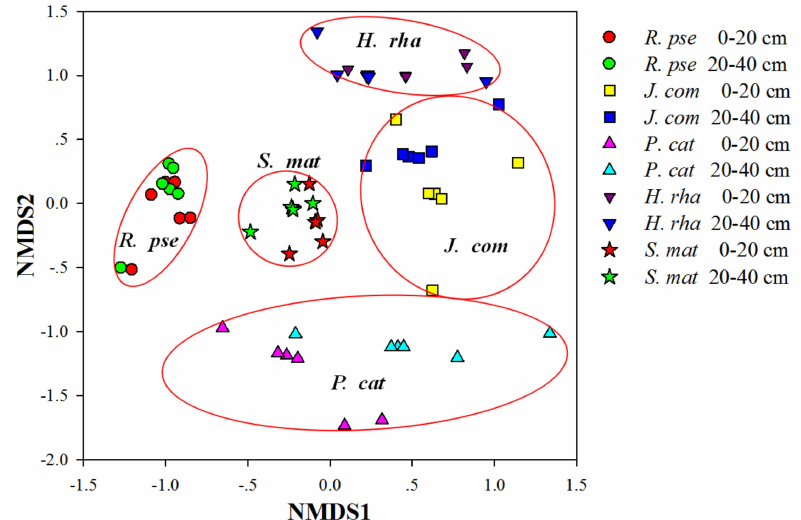
Figure 3. Non-metric multidimensional scaling (NMDS) analysis of the variation in arbuscular mycorrhizal fungal community composition based on the proportion of fungal species ( stress = 0.141). Sixty marks are presented in the NMDS plot, corresponding to the 60 soil samples. Tree species: H. rha , Hippophae rhamnoides ; J. com , Juniperus communis ; P. cat , Populus cathayana ; R. pse , Robinia pseudoacacia ; and S. mat , Salix